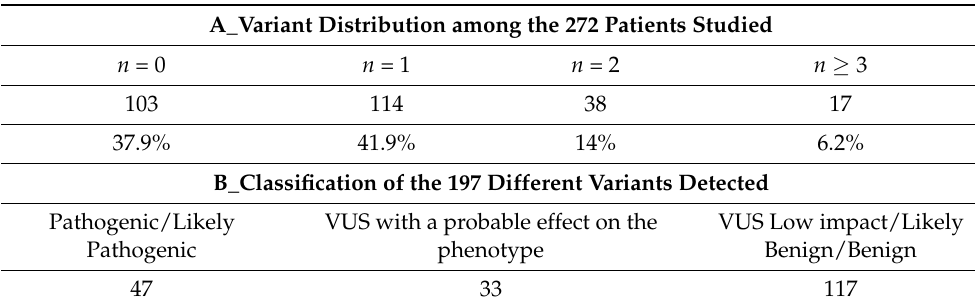
Table 3. Distribution of variants among patients (A) and among predicted effects (B).